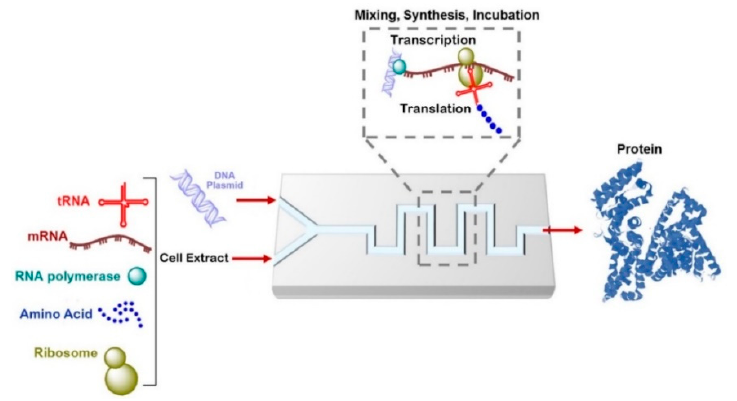
Figure 6. Schematic drawing of cell ‐ free protein synthesis in a microfluidic device. tRNA: transport RNA; mRNA: messenger RNA.